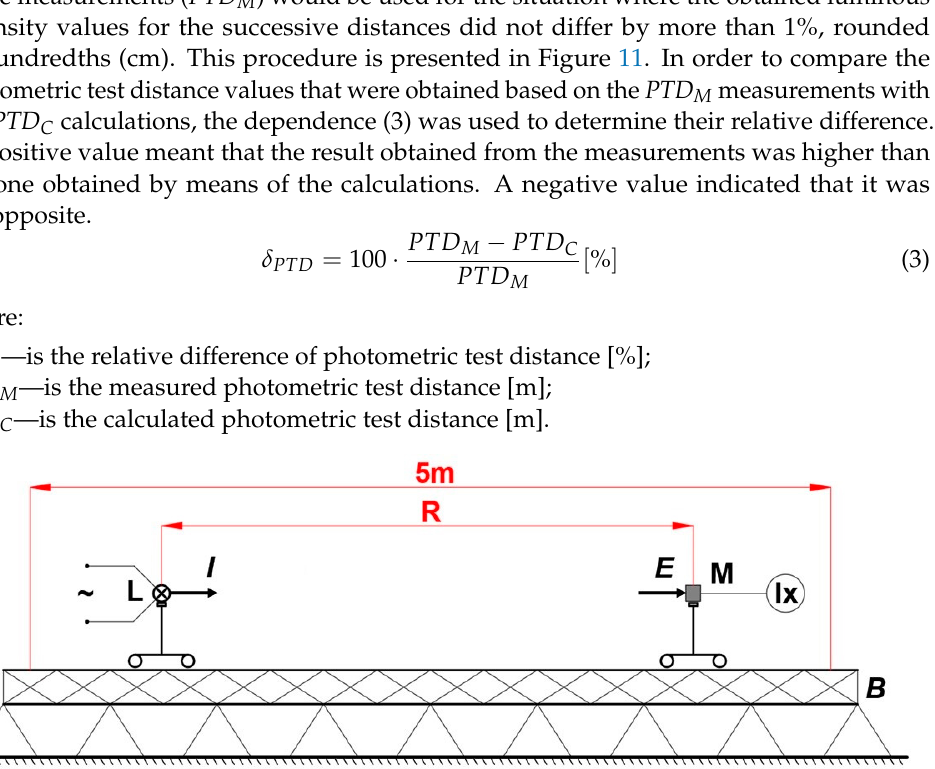
Figure 10. The scheme of the laboratory setup: B—the photometric bench, L—the test luminaire, M—the illuminance meter, R—the distance between illuminance meter and test luminaire, I—the luminous intensity, E—the illuminance.